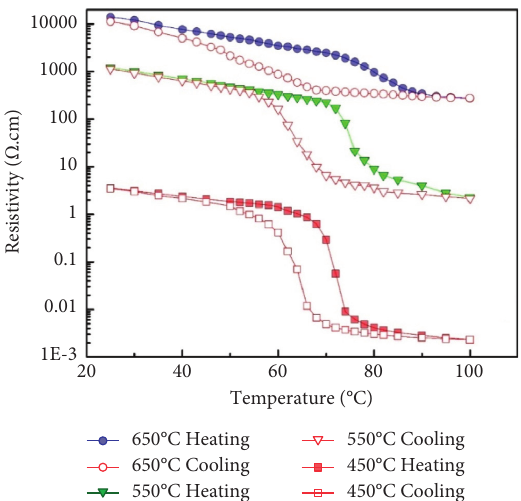
Figure 4: Resistivity versus temperature of the PLD VO